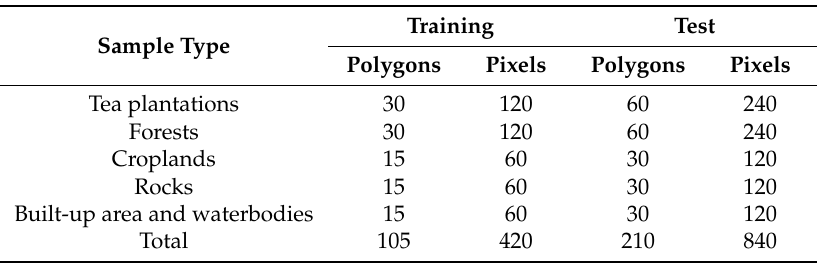
Table 4. Quantities of training and test